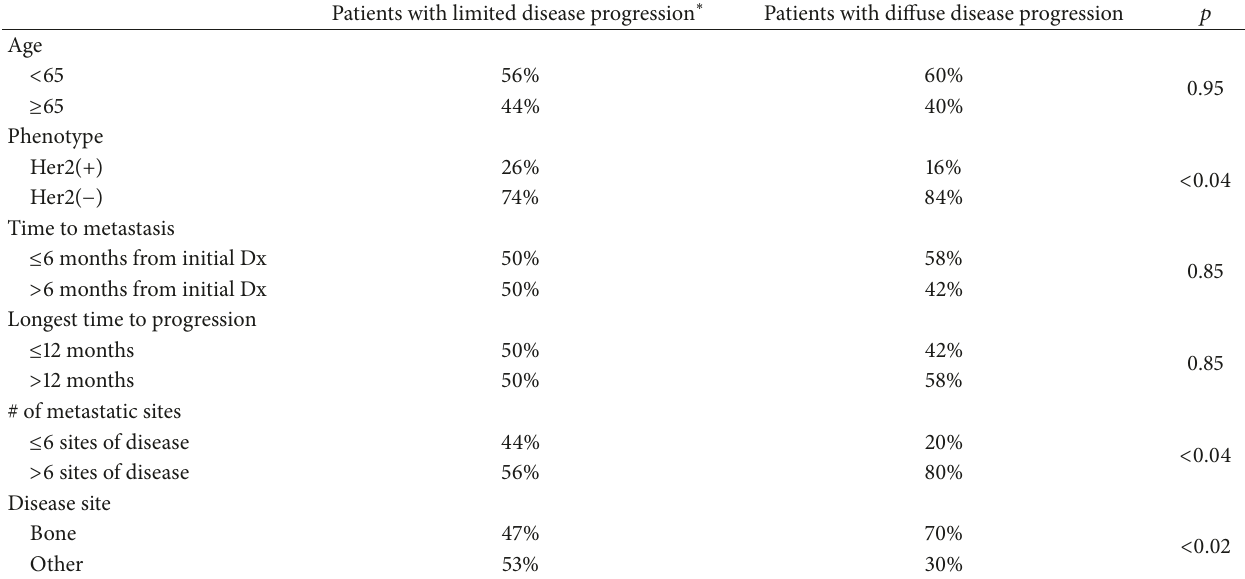
Table 3: Univariate analysis of clinical factors potentially associated diffuse disease progression.